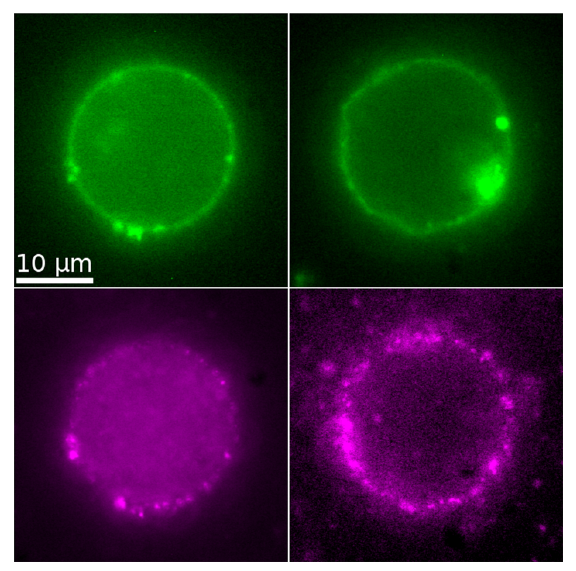
Figure 7: Gel phase vesicles (green) after incubation with particles (magenta). Left: 42 nm particles. The uptake behavior here is compa- rable to the fluid phase situation. Right: 123 nm particles. In contrast to fluid phase vesicles (see Figure 6), the particles adhere strongly to the membrane and some are internalized. However most particles remain bound to the membrane.